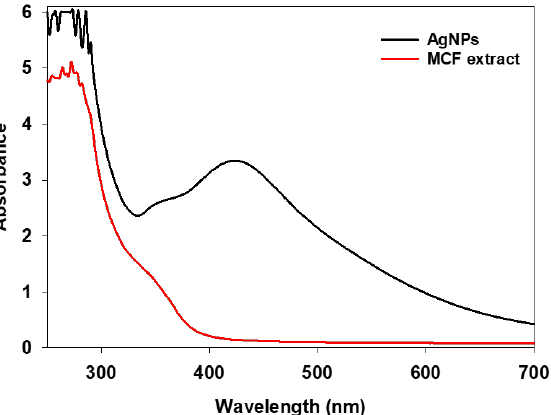
Figure 1. UV-Vis absorption spectra of Morinda citrifolia fruit (MCF) extract and microwave mediated Ag nanoparticle (AgNP) solution.